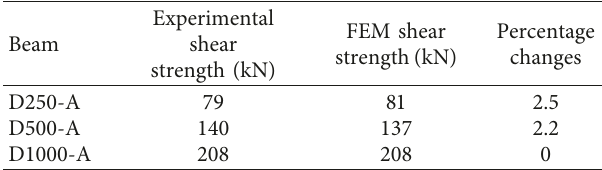
Table 9: Properties of RC beams.